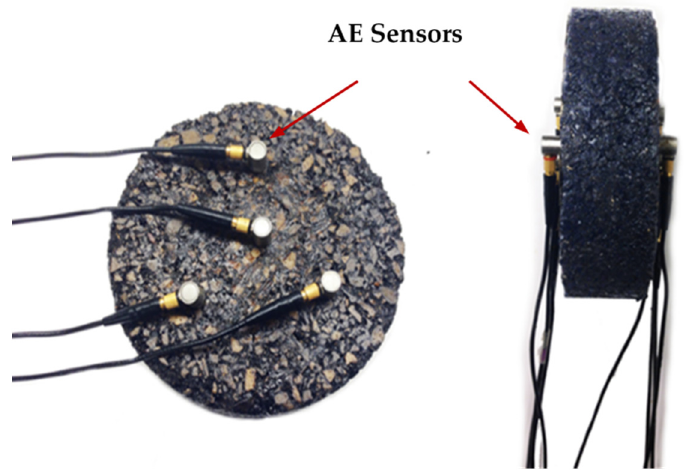
Figure 15. AE source location in asphalt mixture samples using eight piezoelectric sensors with four sensors mounted on each plane side of the specimen. To avoid numerical instabilities, the sensor pattern placed in one surface has a 45° offset angle with respect to the pattern of the opposite surface.